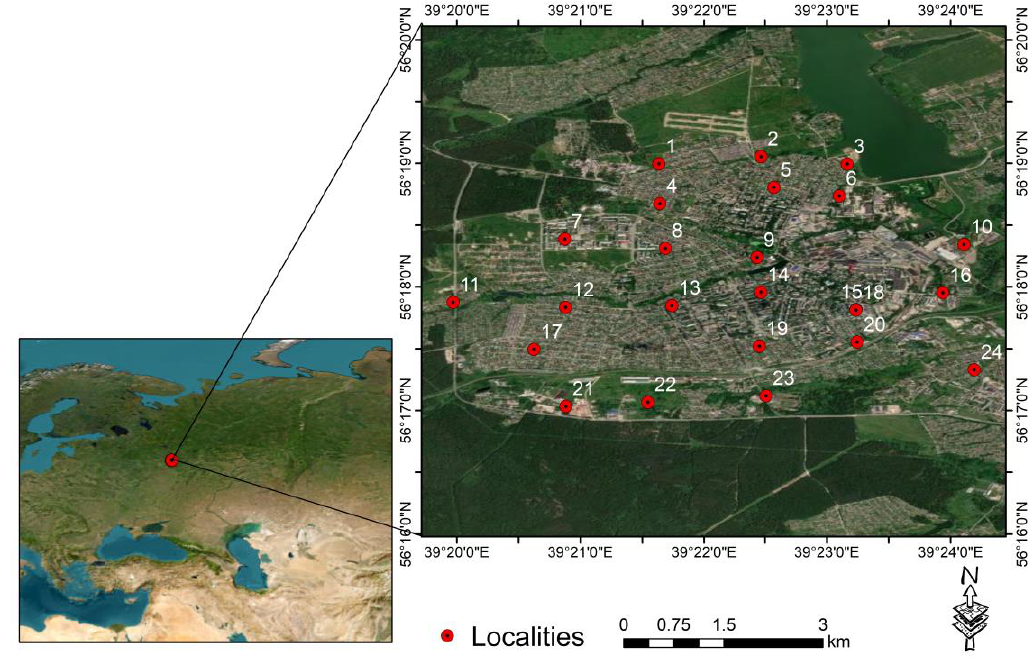
Figure 1. Map of samples’ Figure 1. map of samples’ locations.